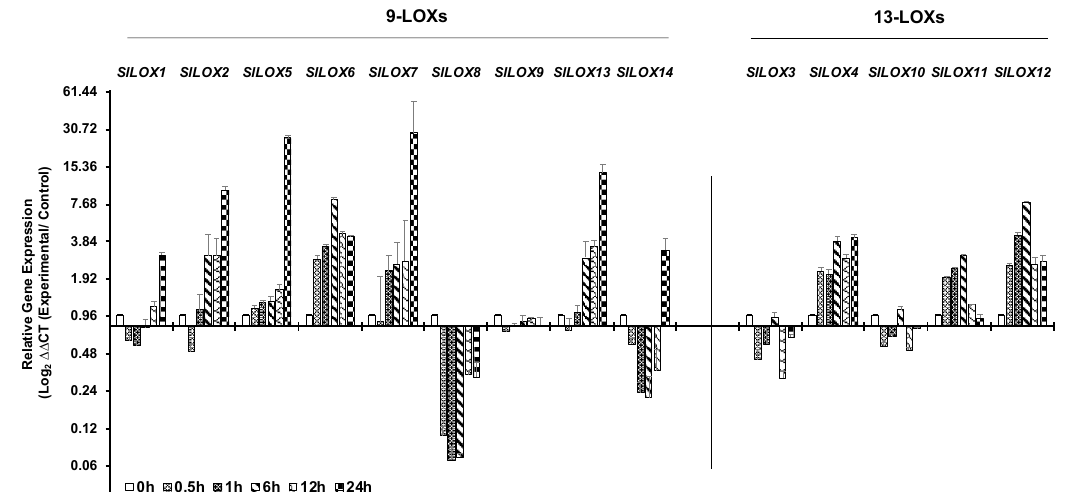
Figure 3. qRT-PCR analysis of tomato ( S. lycopersicum cv. Ailsa Craig) LOX gene family members in response to heat stress. Graphical representation qRT-PCR data of tomato 9- LOX genes and 13-LOX genes in response to heat treatment at 42 °C for up to 24 h. Non-treated control (0 h) was used as a calibrator in the qRT-PCR data calculation and for defining statistical significance of treatment data points at levels * p < 0.05, ** p < 0.01 and *** p < 0.001. Details are given in Figure S1. A minimum of three biological replicates, where each biological replicate was comprised of two technical replicates, were used for each time point. Two housekeeping genes, SlTIP41 and SlUBI3 , were used to normalize the expression of target